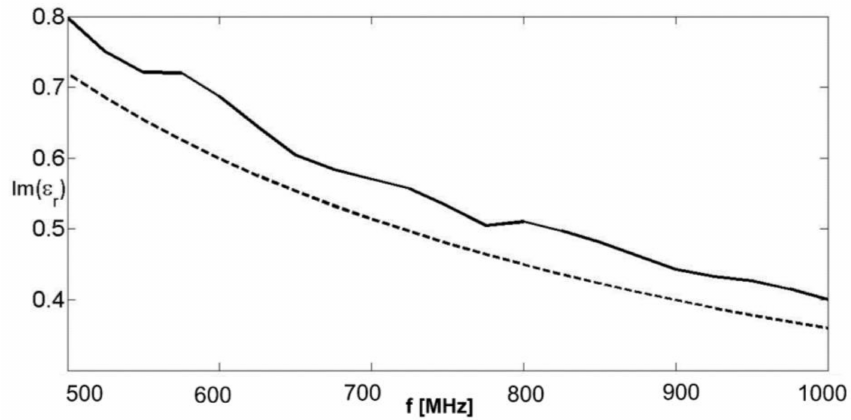
Figure 4. Imaginary part of the equivalent complex permittivity. Solid line: retrieved value; dashed line: actual